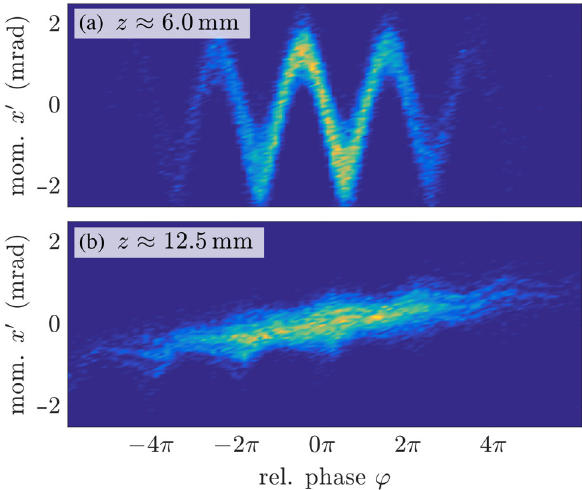
m.FIG. 14. DLA track6 D simulation of the λ chronous DLA undulator with realistic ARES injection param- eters. The plots show the transverse momentum vs the relative phase [cf. (14)] at two different z